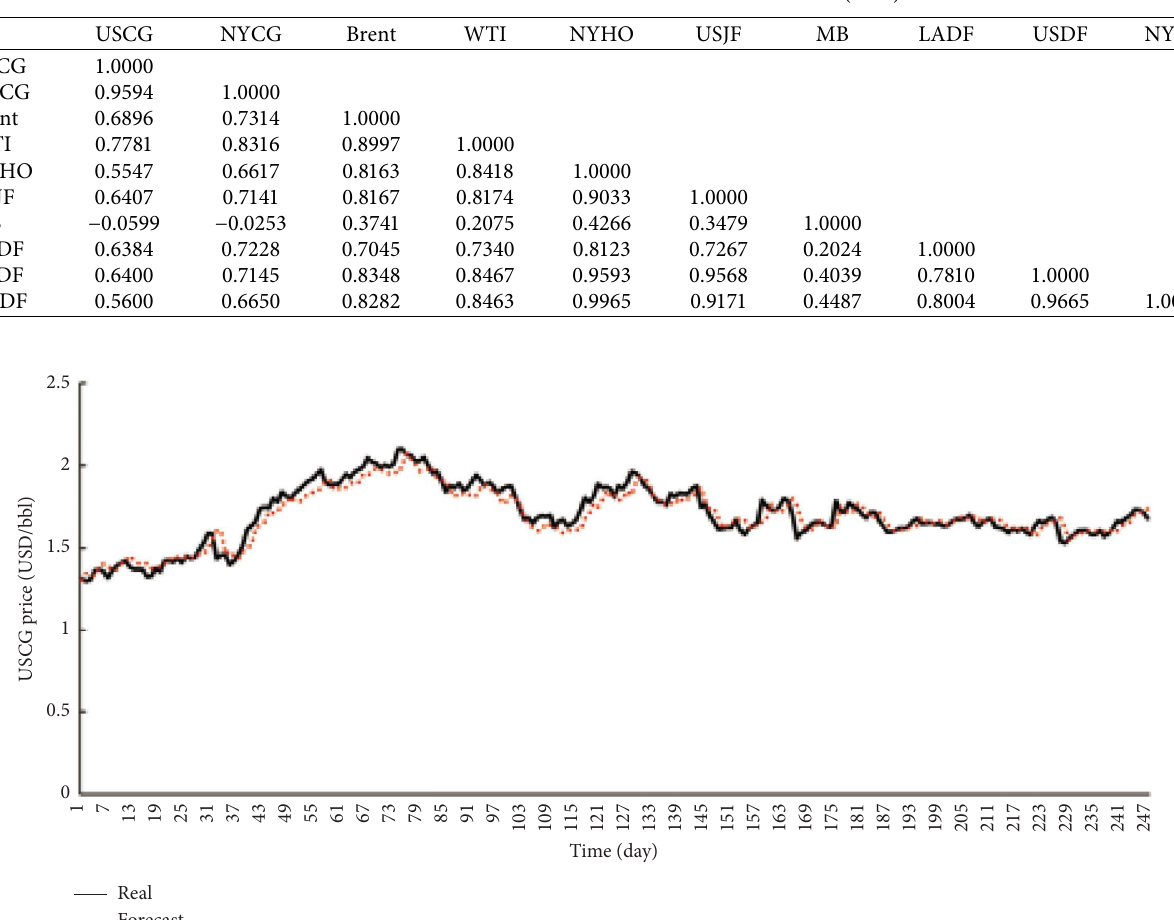
Figure 2: USCG price and correspondent forecast provided by the I-cLV model for lead time t +1 in